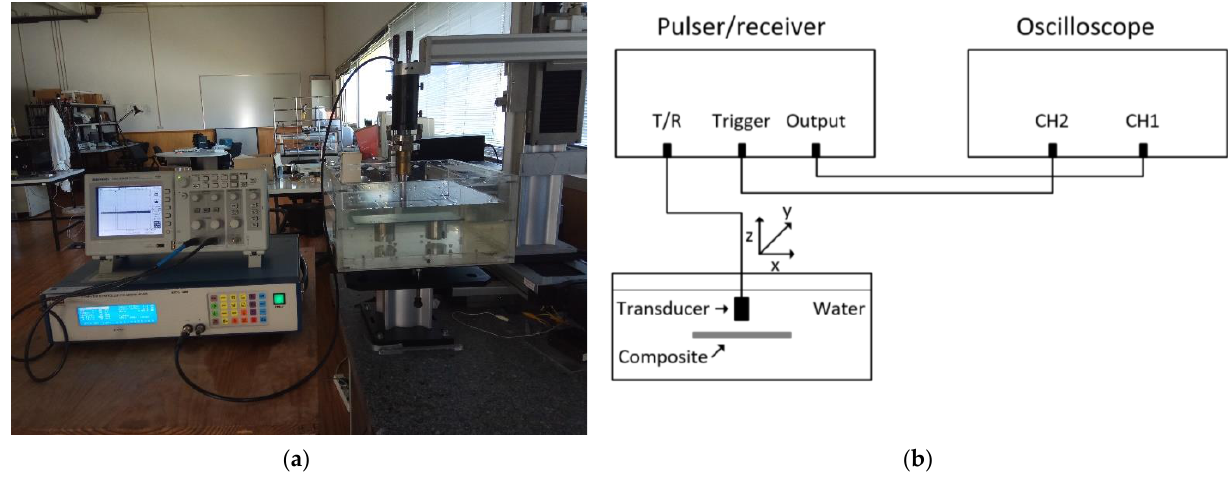
Figure 5. Experimental setup: ( a ) photo; ( b ) schematic.